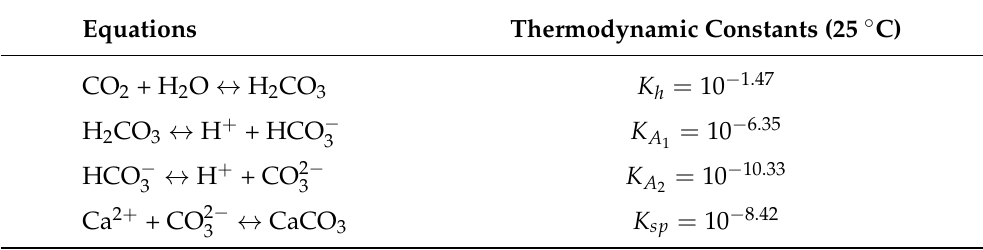
Table 1. Equations for the carbonate system in equilibrium with calcite in aqueous media, e.g.,